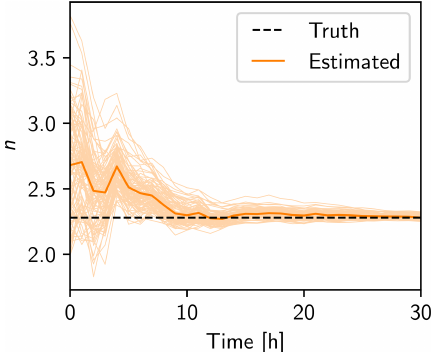
Figure 4. Estimation of parameter n in convergent case 4 (CC4). The ensemble mean is shown in orange and the ensemble in light orange. The truth is a black dashed